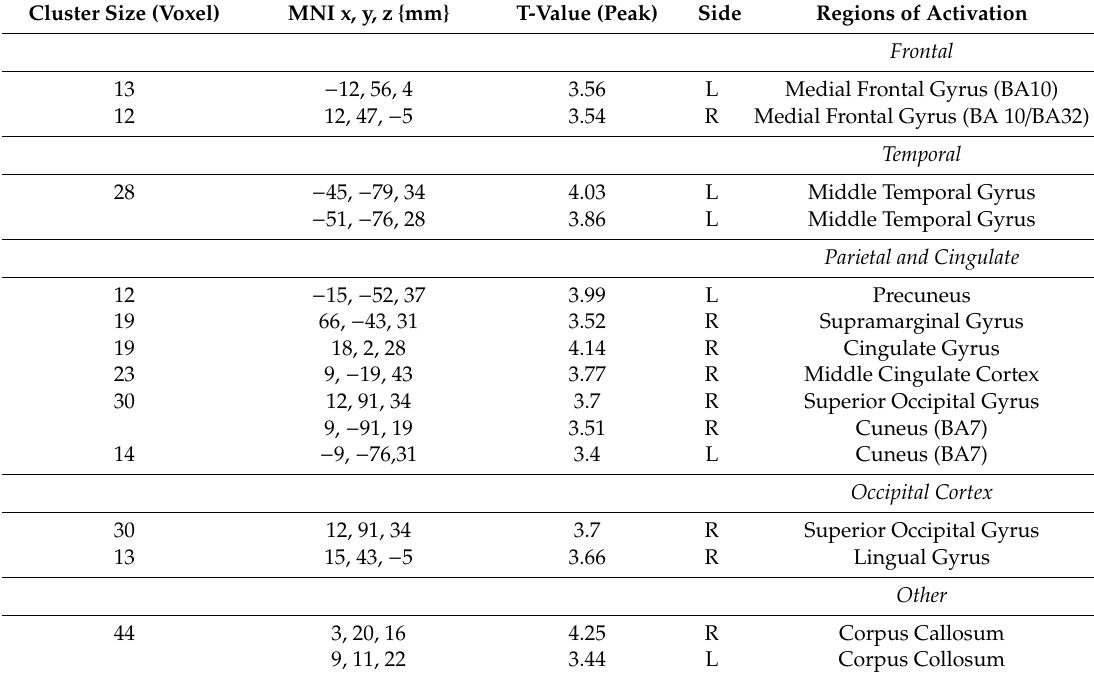
Table 4. Subtraction analysis: Familiar CS > Novel CS 1